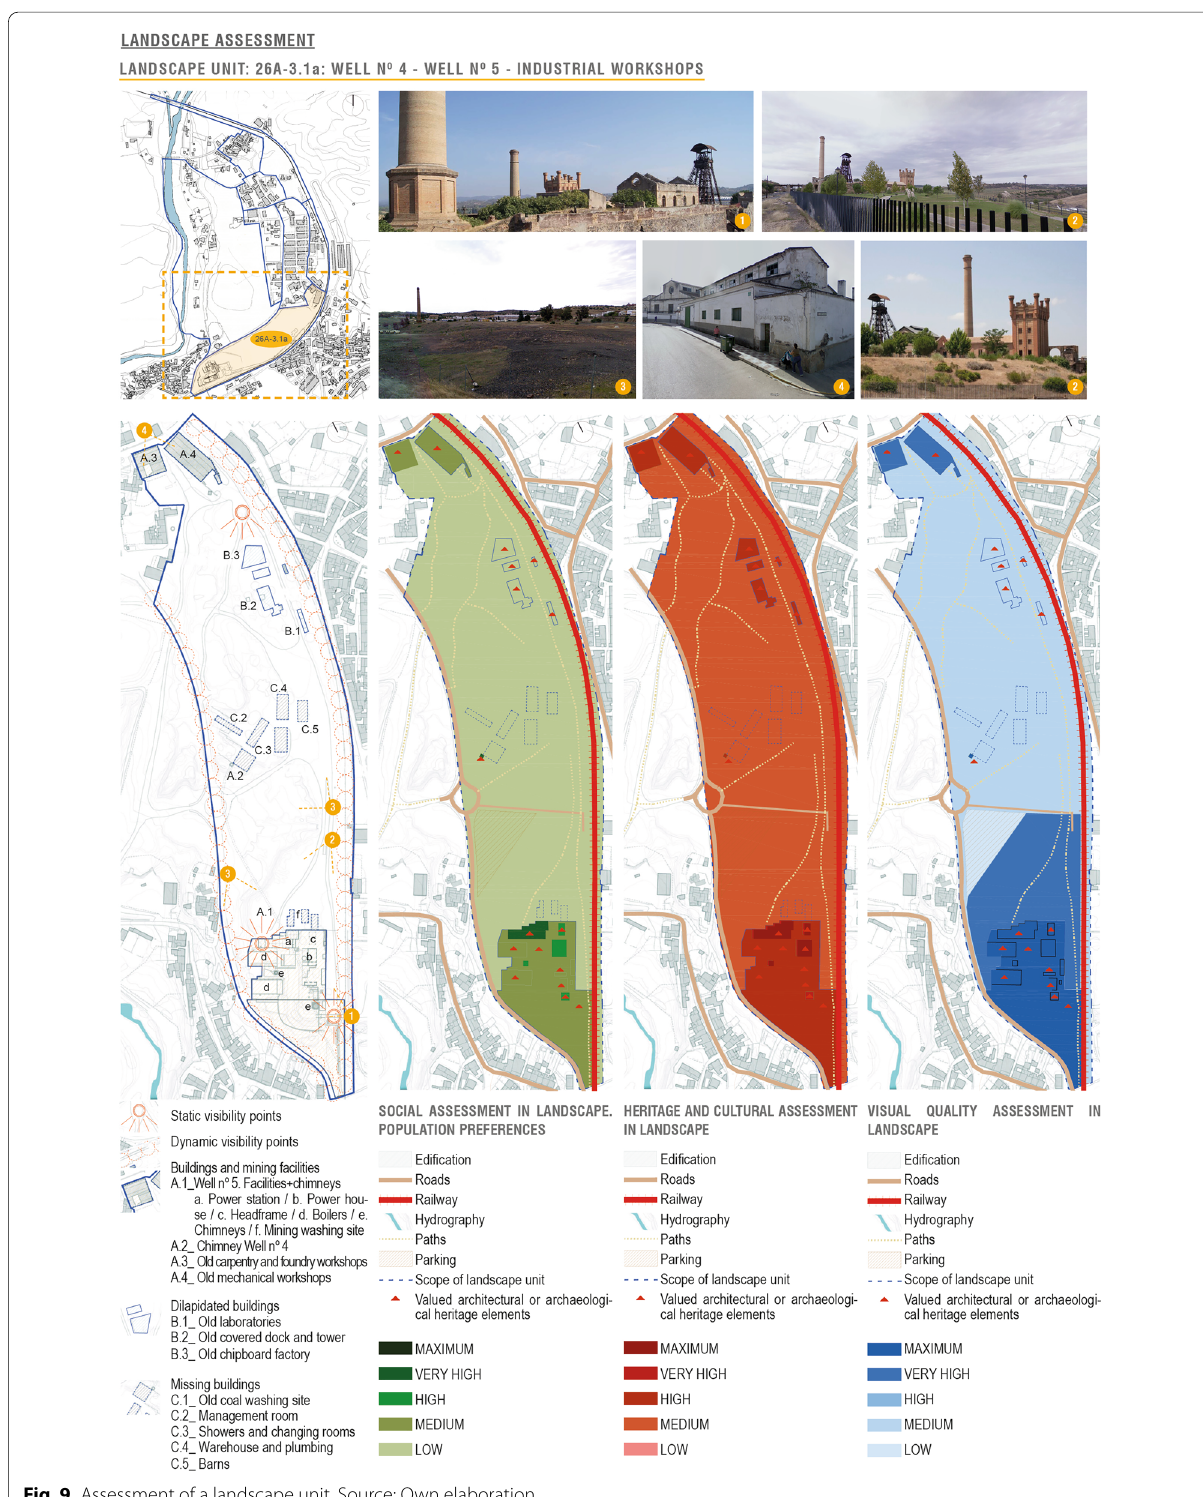
Fig. 9 Assessment of a landscape unit. Source: Own